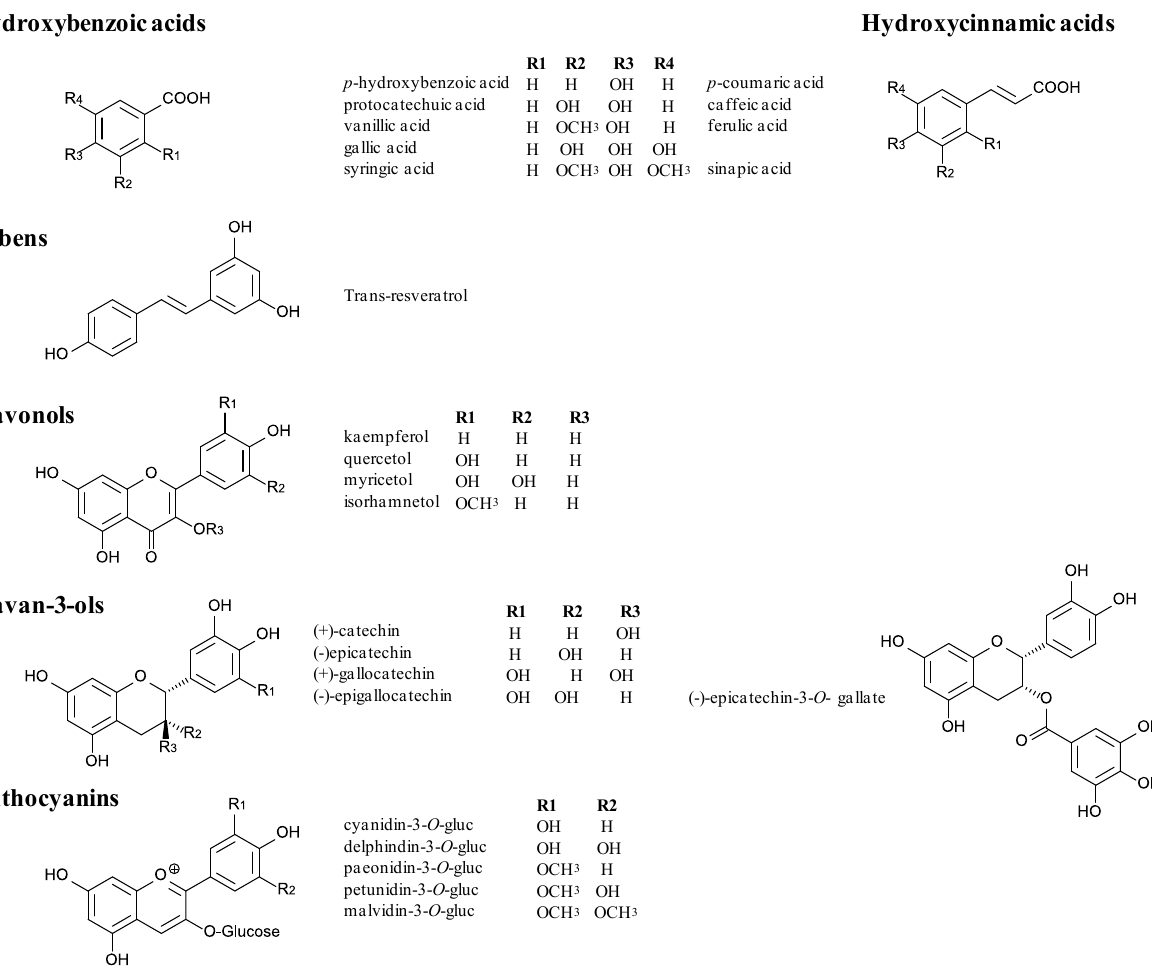
Figure 1. Structures of important monomeric phenolic compounds in grapes and